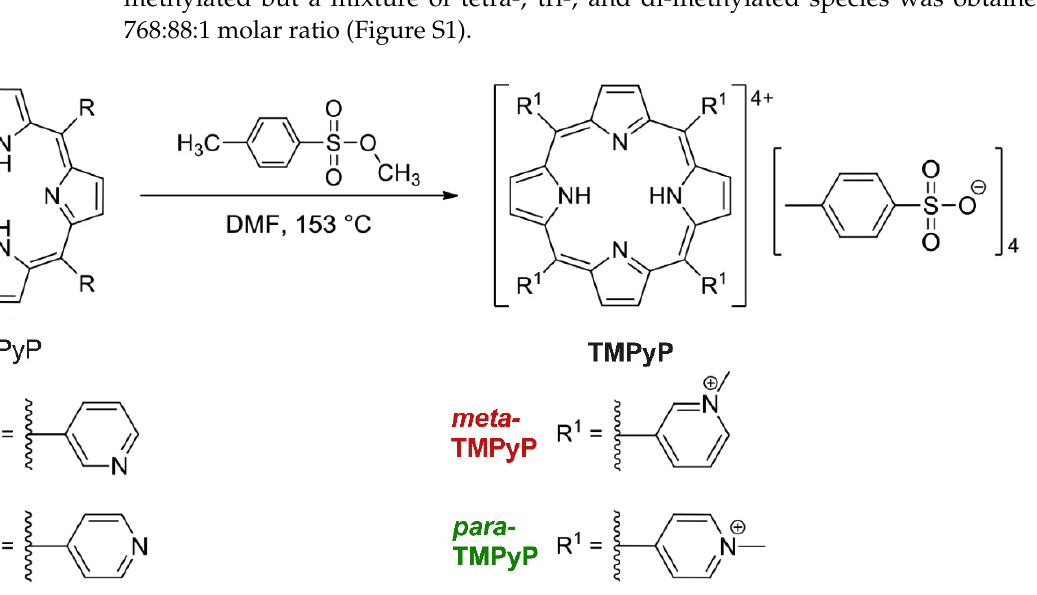
Figure 2. Synthesis reaction scheme of the variants meta -TMPyP and para -TMPyP For synthesis, the respective porphyrin ( meta -TPyP or para -TPyP) was heated with the methylation reagent para - toluenesulfonic acid methyl ester (methyl tosylate) (100 equivalents, 25-fold excess based on the porphyrins) in the dried solvent N , N -dimethylformamide (DMF) for 18 h under light exclusion and argon atmosphere under reflux at 153 °C. Purification was performed by precipitating the product with acetone and washing an aqueous solution of the product with dichloromethane. The meta - TMPyP product was obtained in 87% yield as a purple solid, while synthesis of para -TMPyP yielded 85% of the product as a purple solids.